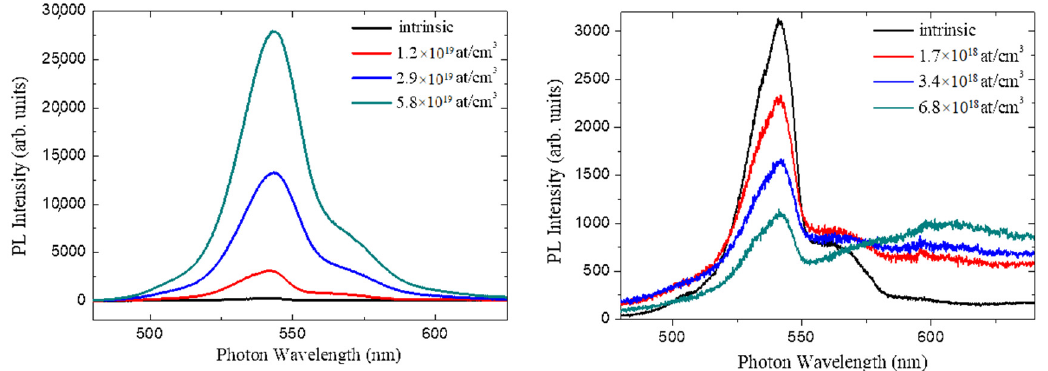
Figure 2. PL spectra, centered at 540 nm, acquired on the surfaces of the N-type ( left panel ) and P-type ( right panel ) samples.